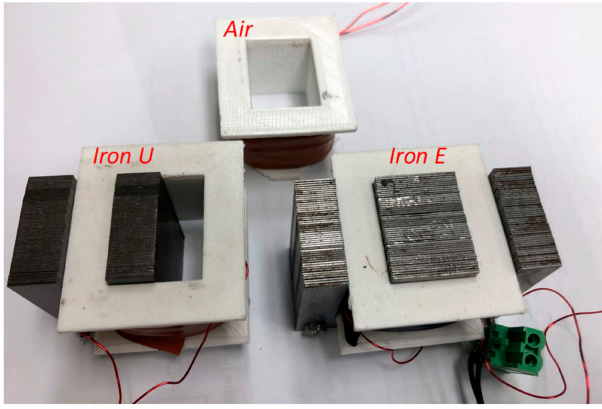
Figure 1. Flux sensors: Air, iron core U and iron core E.